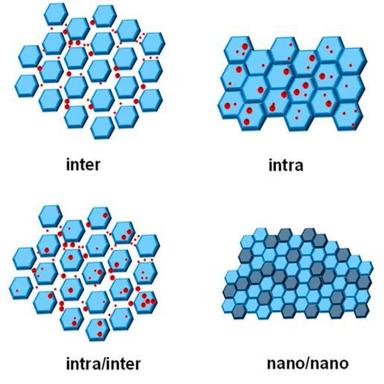
Classification of different types of (nano)composites after Niihara et al..